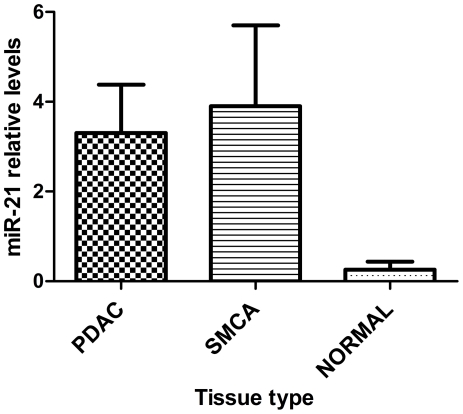
RT-qPCR confirmed miR-21 overexpression in PDAC and SMCA compared to normal pancreas.This suggests that miR-21 overexpression may be an early event in the formation of pancreatic BCT from normal pancreas. MiR-21 was unable to differentiate PDAC from SMCA and therefore it may be questionable as a future biomarker of PDAC. RNA was isolated from FFPE samples for all 3 tissue types. (Results presented as mean±SEM).